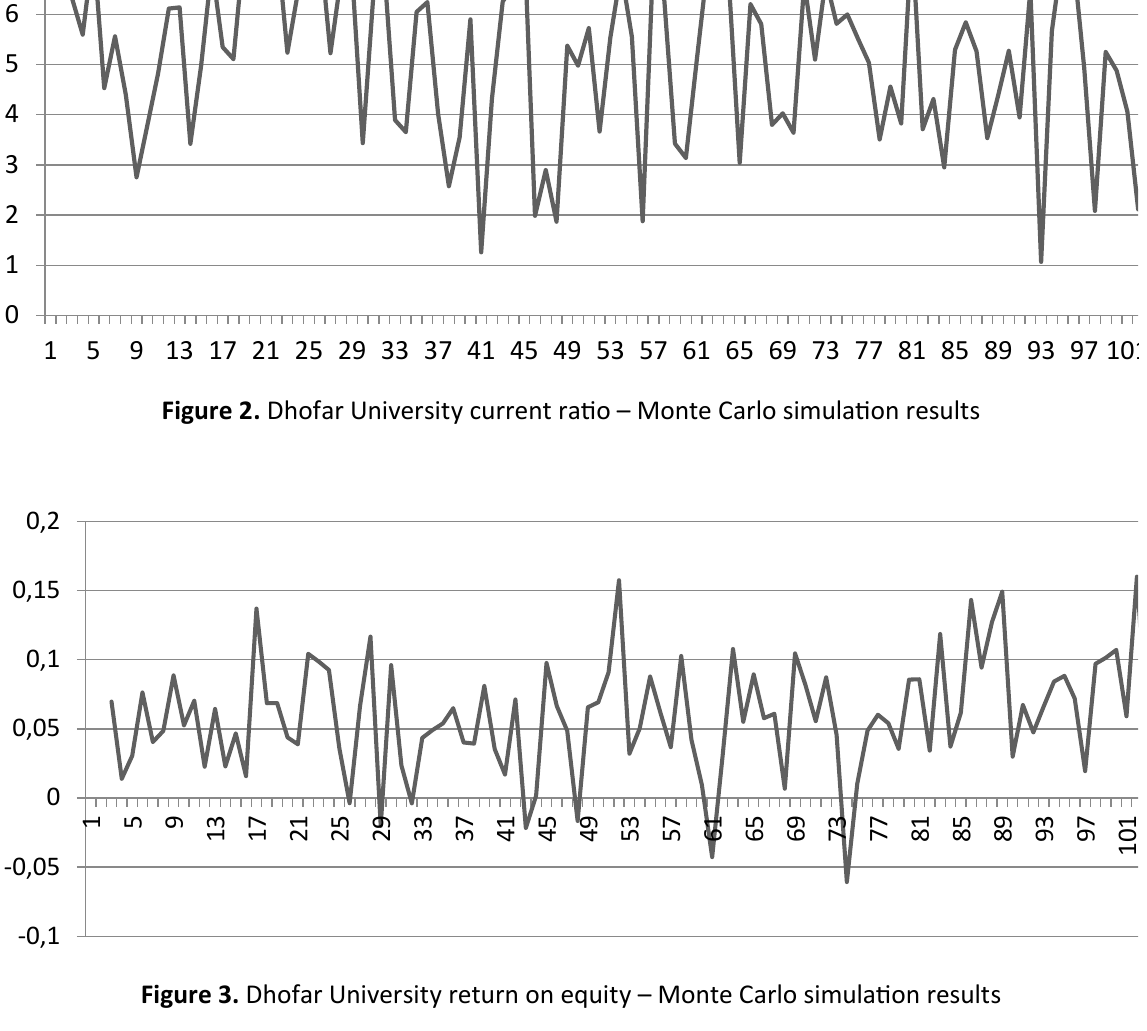
Figure 3. Dhofar University return on equity – Monte Carlo simulation results